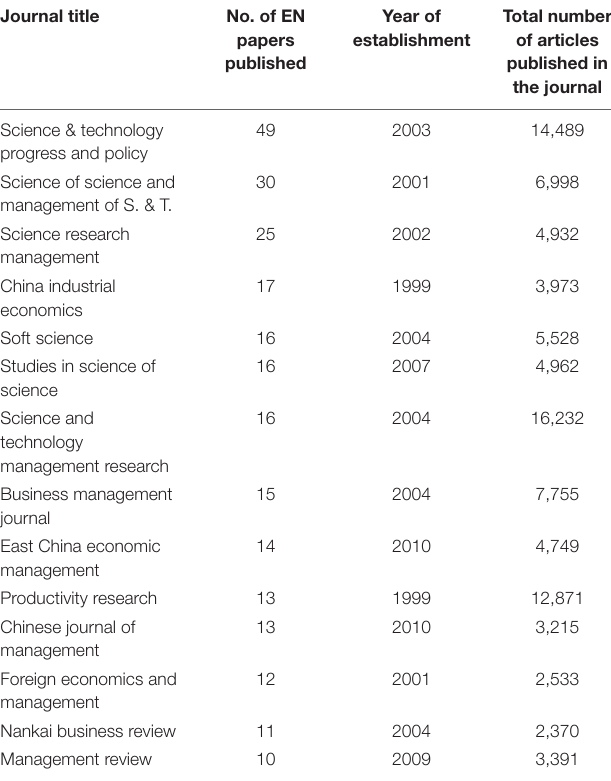
TABLE 1 | The number of EN papers published in CSSCI journals (No. > 10).